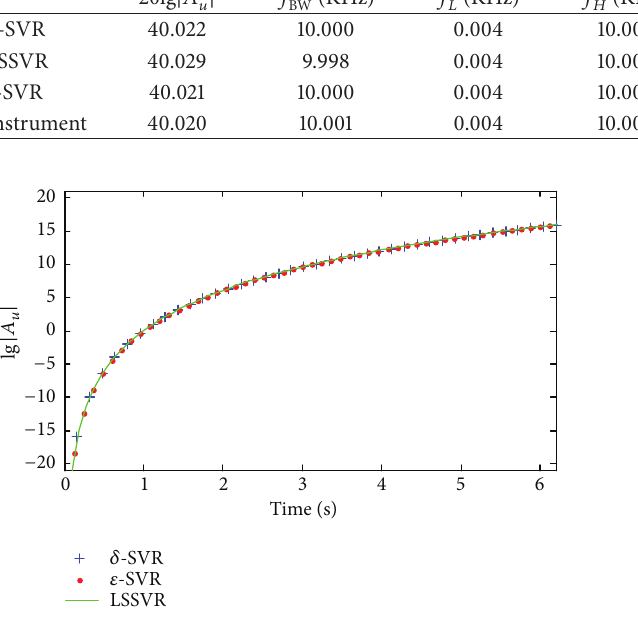
Figure 2: Local regression curve of gain 20 lg | A methods.